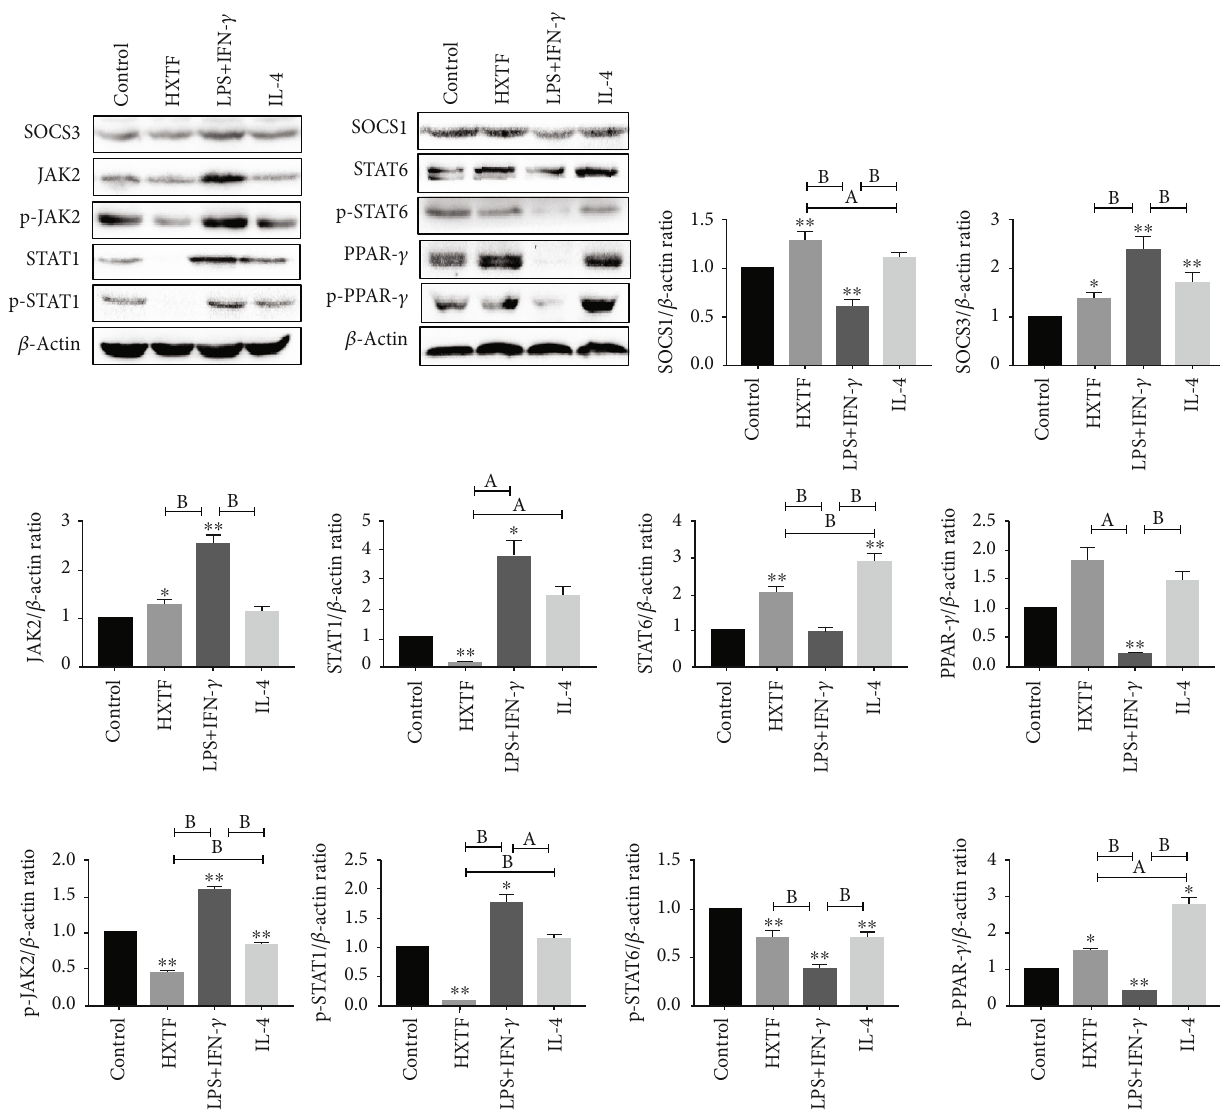
Figure 4: SOCS/JAK2/STAT/PPAR- γ pathway in HuoXueTongFu Formula- (HXTF-) induced macrophage polarization. RAW264.7 macrophages were incubated during 12 h with the control DMEM solution, LPS+IFN- γ , IL-4, and HXTF, respectively. Whole protein was extracted, and each protein expression was assayed by Western blotting. All values are expressed as mean ± S : E : ( n = 3 experiments). ∗ p < 0 : 05 , ∗∗ p < 0 : 01 , a p < 0 : 05 , and b p < 0 : 01 , comparison of the designated two